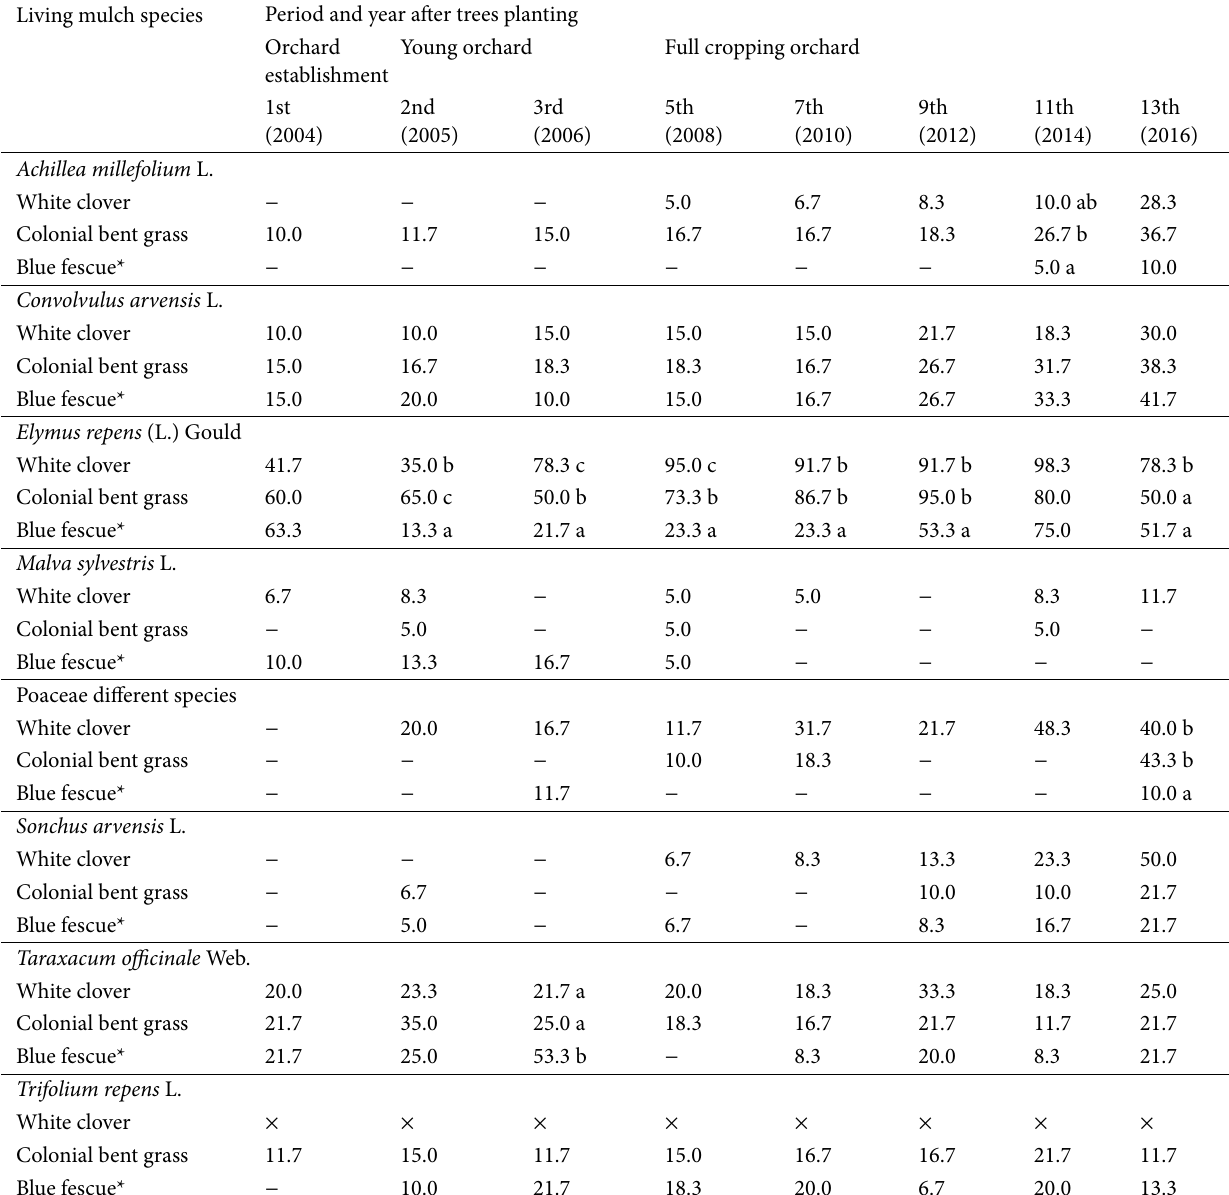
Table 6 Differences between three living mulch sods in the mean percentage of soil surface under the most important perennial weed cover in the tree rows, in the succeeding years 2004 −